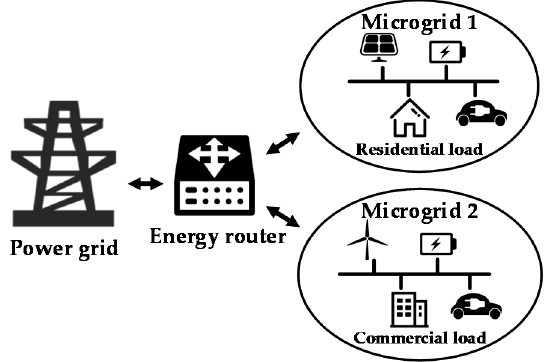
Figure 1. Energy router-based interconnecting framework for the microgrids system.